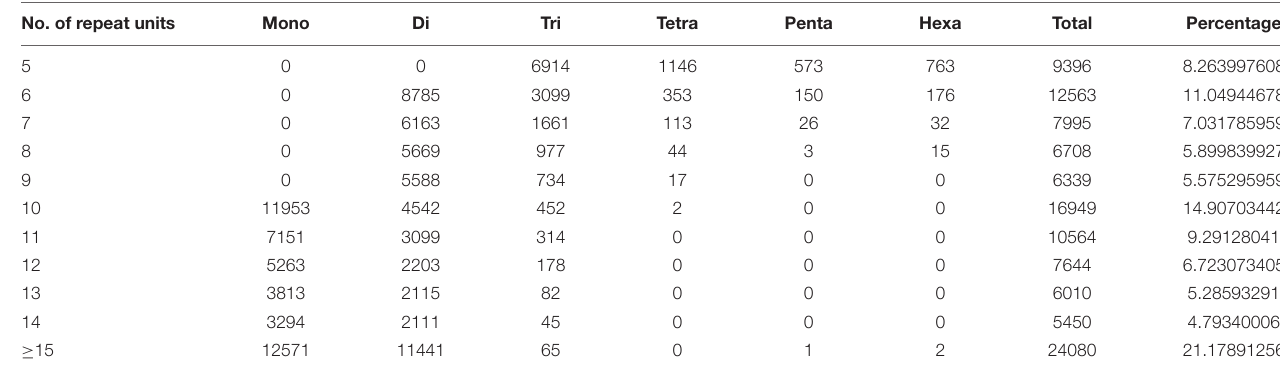
TABLE 6 | SSRs distribution based on the number of repeat